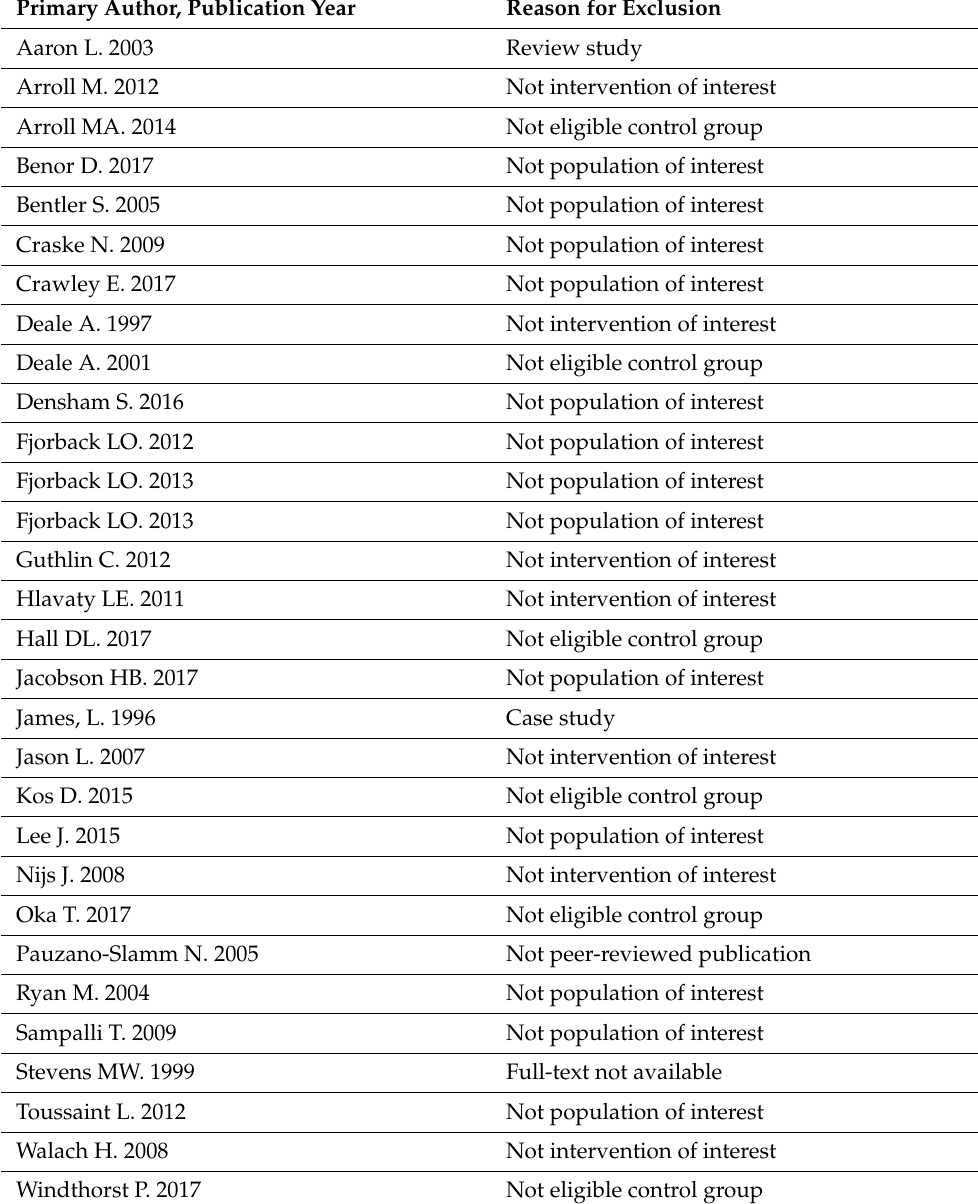
Table A2. Excluded